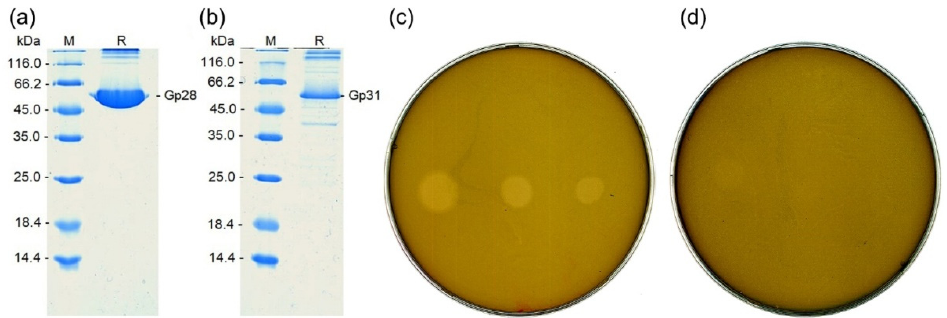
Figure 9. The properties of Bolokhovo (Gp28) and Novomoskovsk (Gp31) recombinant depolymerases. ( a , b) The composition of Gp28 and Gp31 preparations determined by sdsPAGE. Track M—Molecular weight markers (Thermo Scientific, No. 26610). ( c , d) Spot tests of Gp28 and Gp31 (respectively) on B. pumilus VKM B-23. On each plate, enzyme concentrations were: Left spot—500 ng, middle spot—50 ng, right spot—5 ng. Five microliters of Buffer D were used as control samples (spots are unobservable).